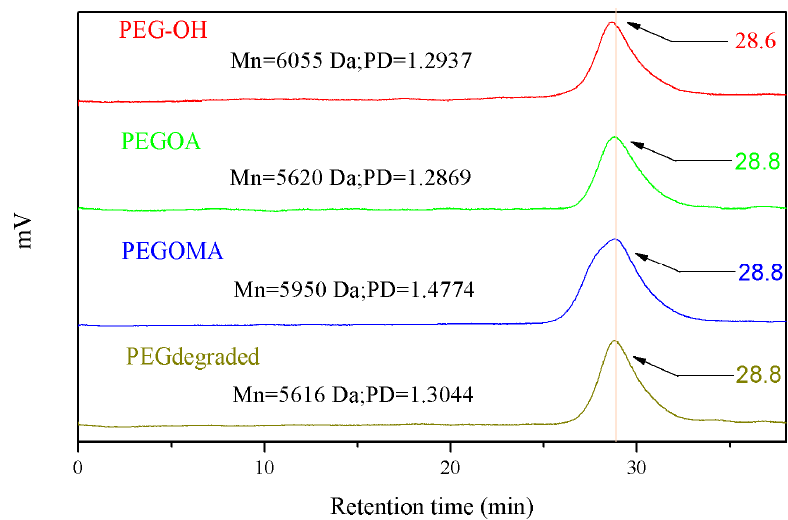
Figure 5. Gel Permeation Chromatography (GPC) analysis of 8PEG-OH, PEGOA, PEGOMA and degradation product of PEGOA-PEGOMA hybrid gel template.